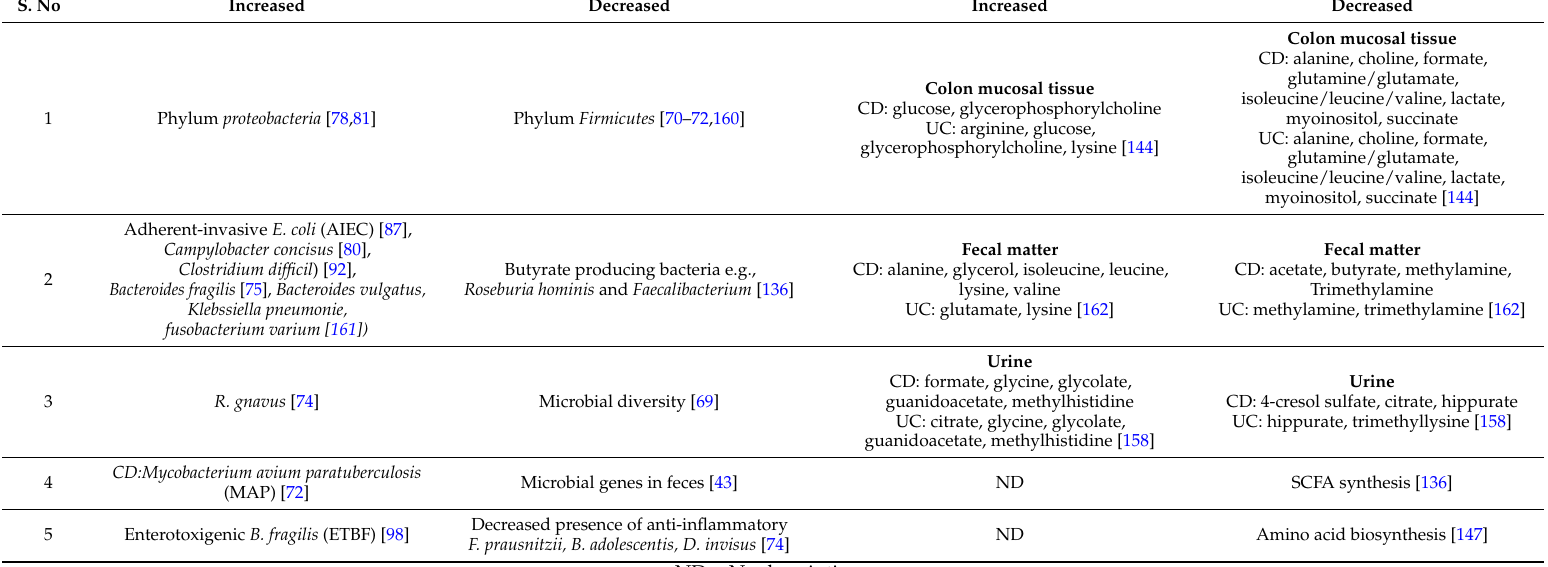
Table 1. Alterations in the microbiome and metabolome during